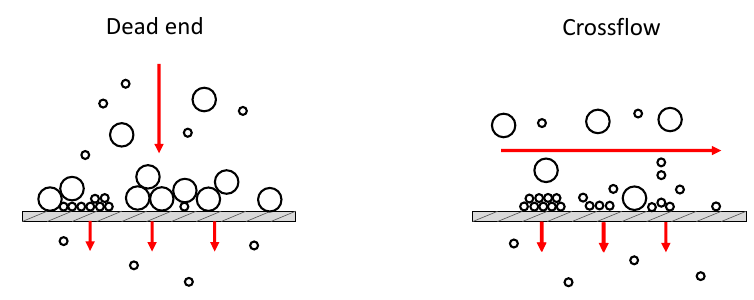
Figure 4. Dead end and crossflow filtration modalities.